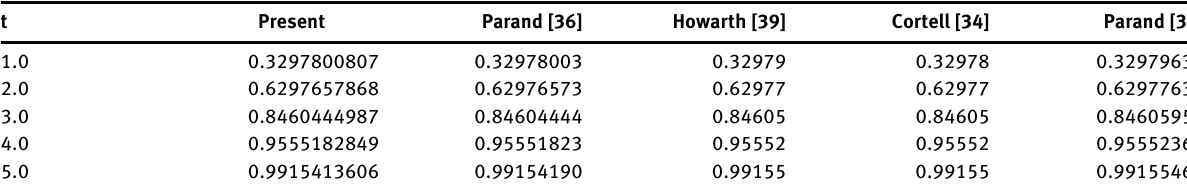
Table 12: Comparison of the obtained values of y ′ ( t ) for various values of t by the present method, Parand et al. [3, 36], Howarth [39], and Cortell [34] t Present